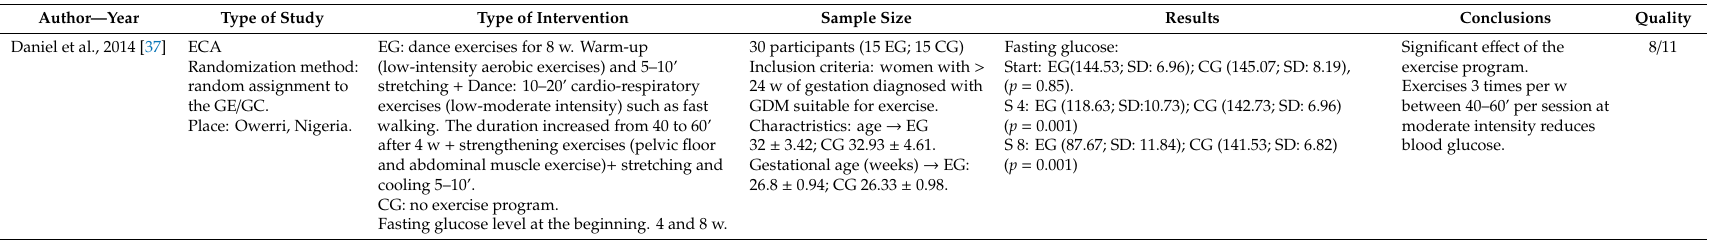
Results Conclusions